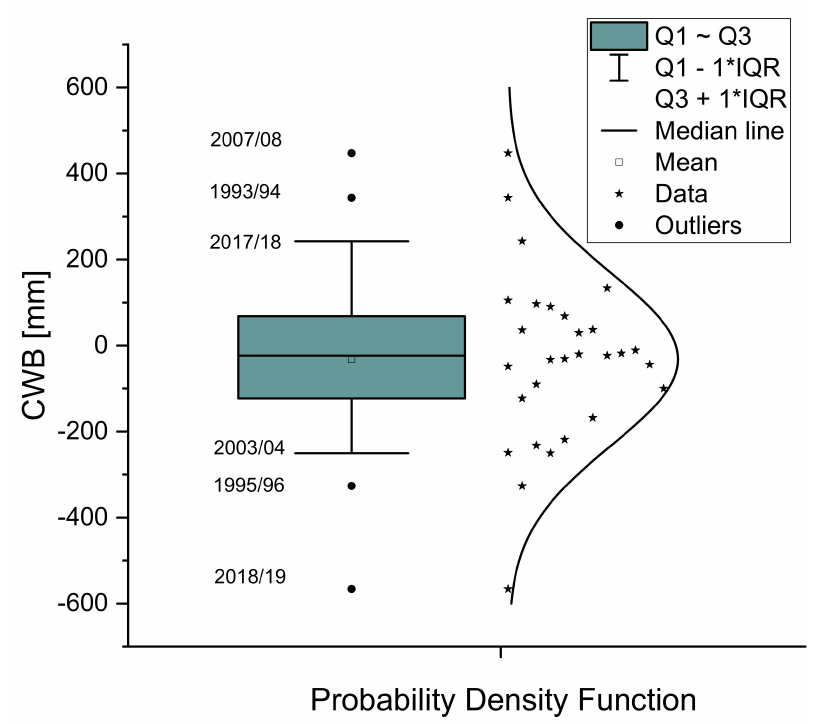
Figure 2. Box plot and probability density function of the Climatic Water Balance for the identification of years with extreme weather conditions during the study period